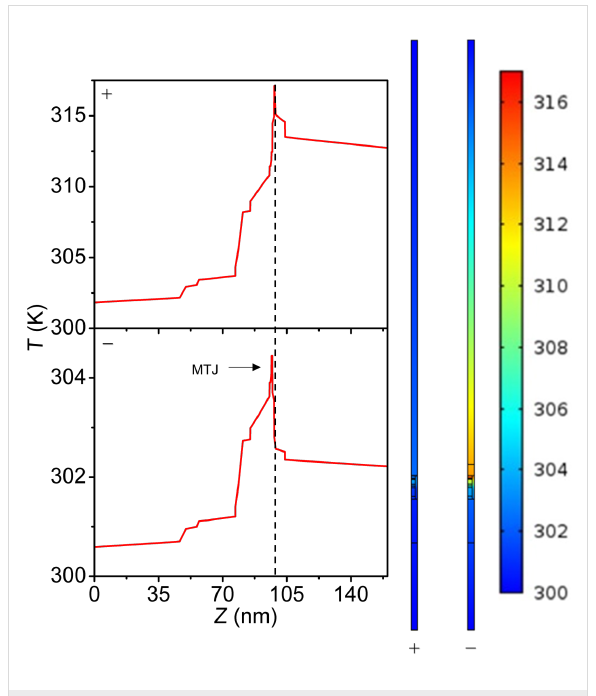
Figure 6: Thermal profiles of configuration IV with SiO 2 passivation with an applied voltage of 0.3 V in “positive” polarity (top) and “nega- tive” polarity (bottom). The left panels show the temperature as a func- tion of the vertical position. The dotted line in the plots represents the center of the MTJ. Note the asymmetry around the MTJ. The free layer in the magnetic tunnel junction reaches ca. 316 K in positive polarity while it only reaches ca. 303 K in negative